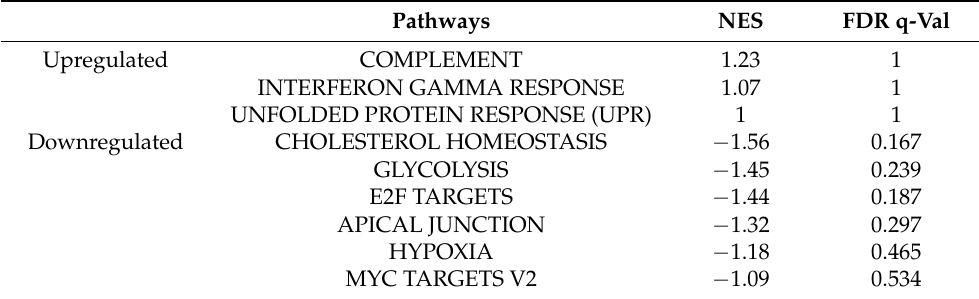
Table 2. Significant up and downregulated pathways in JTB downregulated condition in MCF7 BC cells, according to GSEA analysis with FDR < 25%.